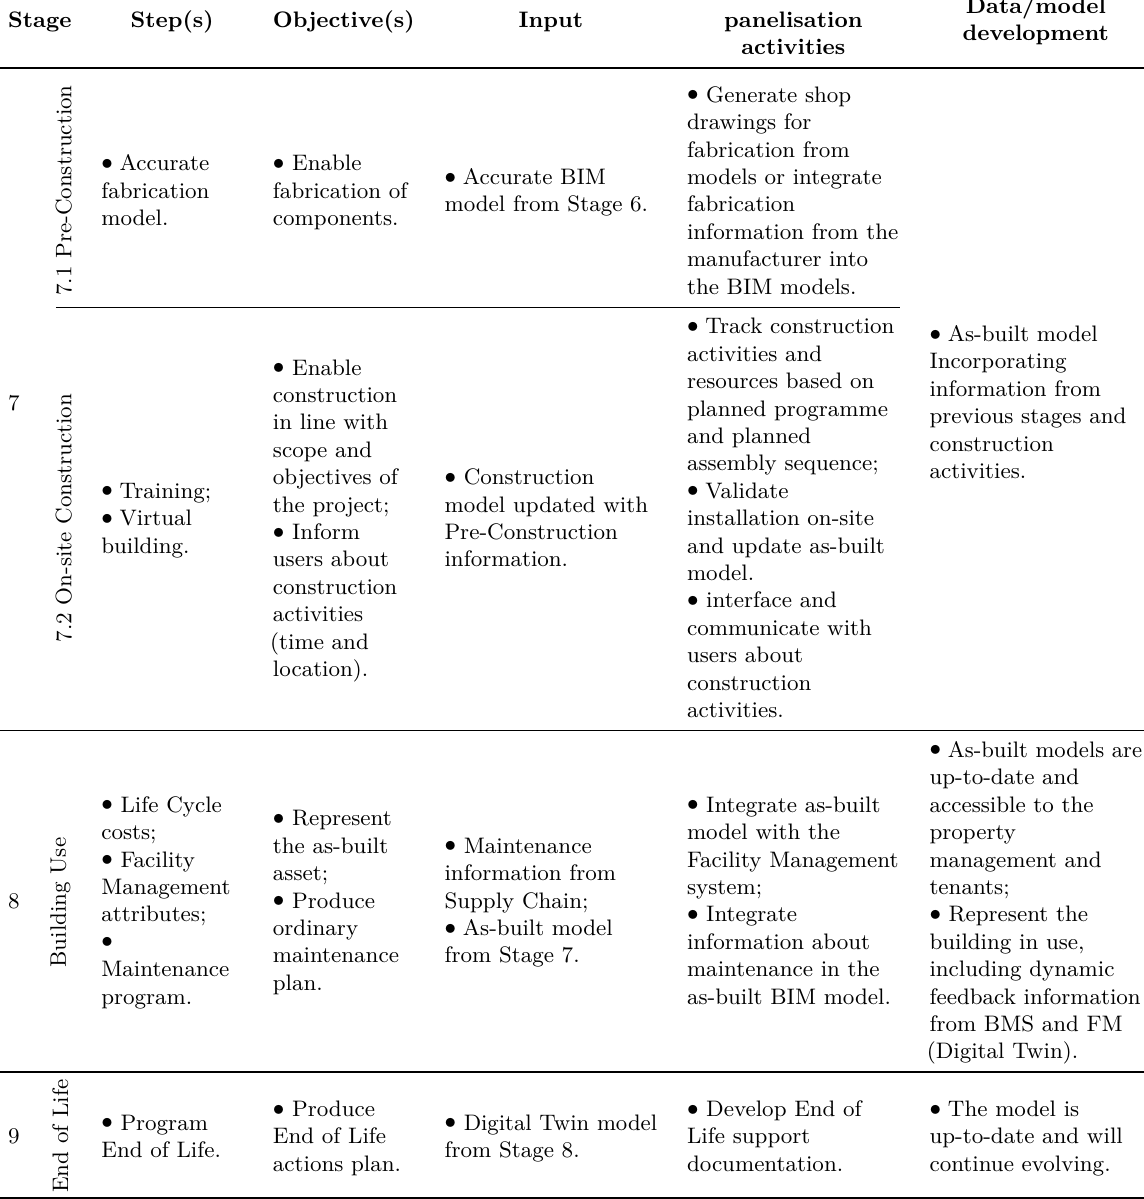
Table 1. Process Matrix for energy retrofit with off-site façade